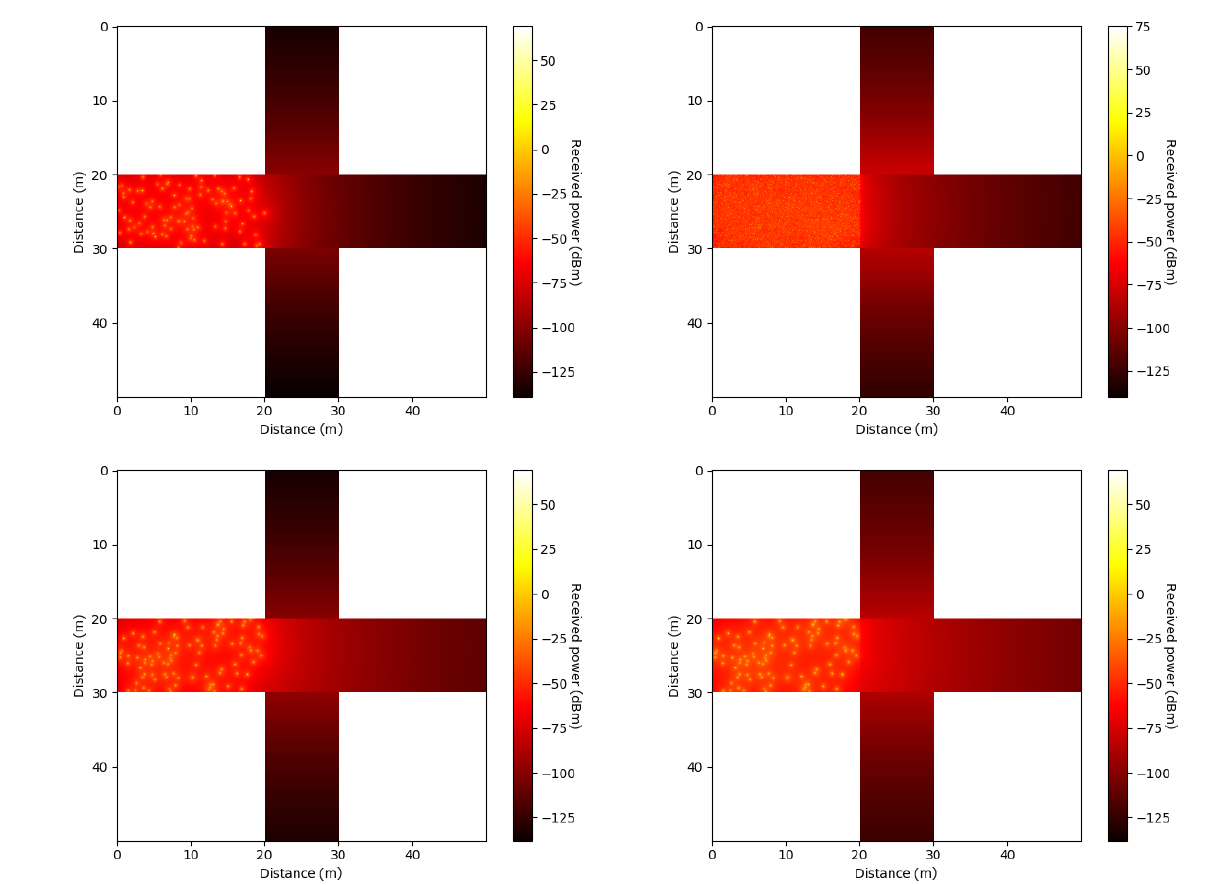
Figure 5. Heat map for the isotropic antenna ( top left ), beamforming with mutation strategy-based particle swarm opti- mization algorithm (MSCPSO) ( top right ), beamforming with the GA ( bottom left ), and beamforming with neuroevolution of augmenting topologies (NEAT) ( bottom right